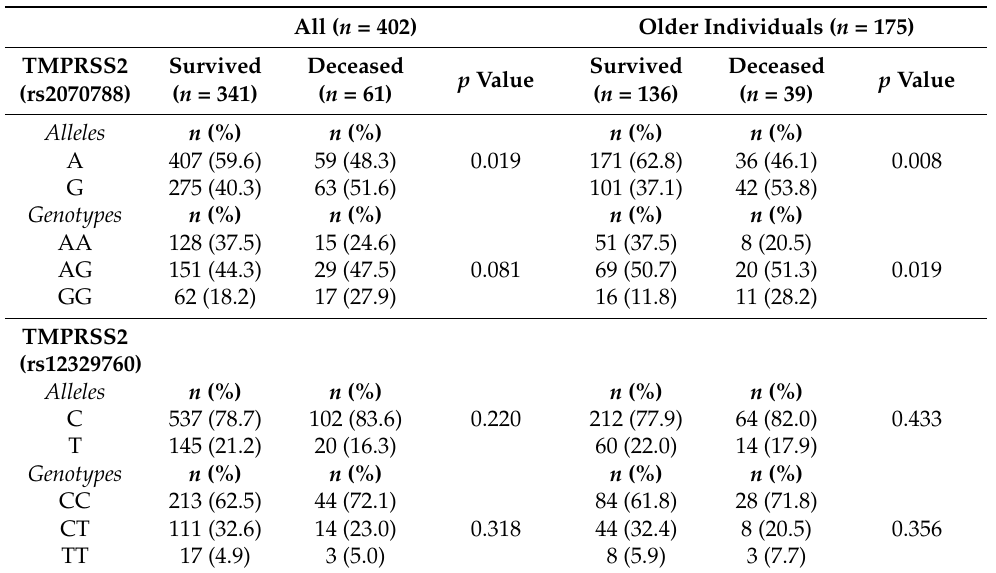
Table 2. Allelic and genotypic distribution of rs2070788 and rs12329760 variants of TMPRSS2 accord- ing to outcome.